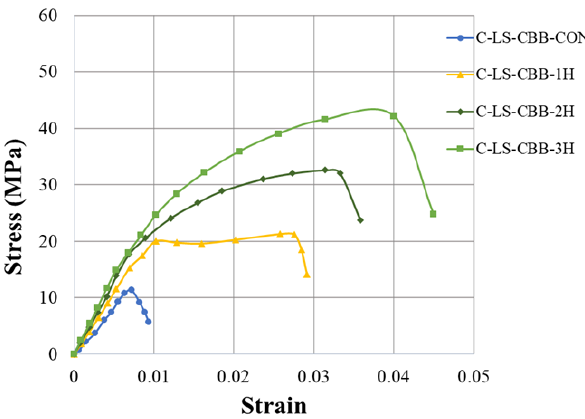
Figure 7. Stress–strain response of Type-1 concrete with and without hemp ropes Figure 7. Stress – strain response of Type-1 concrete with and without hemp ropes confinement.